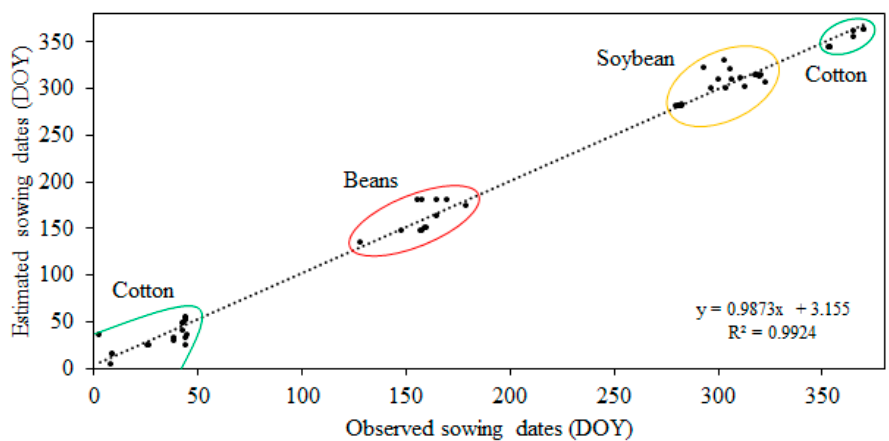
Figure 3. NDVI-derived sowing dates versus field sowing dates.